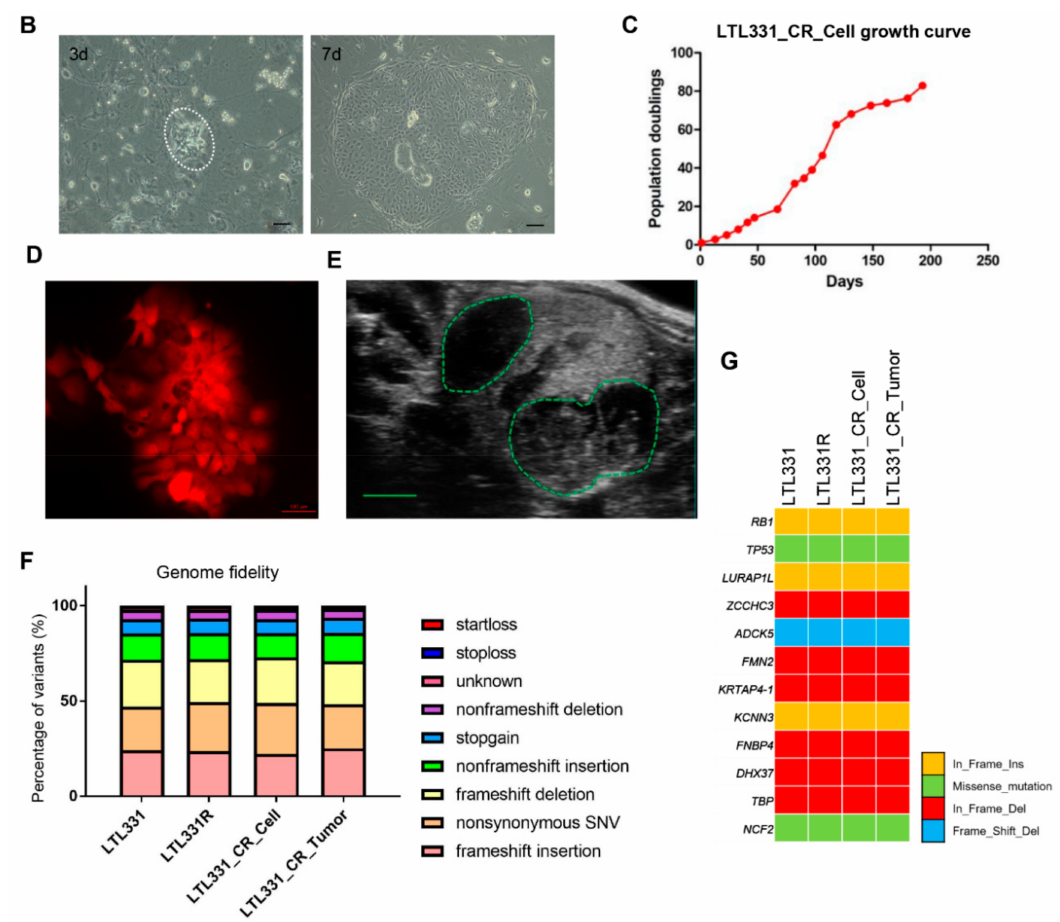
Figure 1. Establishment, application, and molecular characterization of conditionally reprogrammed cells derived from the LTL331 PDX. ( A ) Schematic showing the conditional reprogramming (CR) culture establishment process. The LTL331 prostatic adenocarcinoma PDX can transdi ff erentiate to neuroendocrineprostatecancer(NEPC)(LTL331R)afterhostmousecastration-inducedtumorregression (LTL331_Cas) [10]. Fresh tumor tissue from LTL331 was enzymatically dissociated into single cells. The cells were then cocultured with irradiated 3T3-J2 feeder cells to establish LTL331_CR_Cells. The CR cells were grafted under the renal capsule of host mice to establish CR cells-derived xenografts, namely LTL331_CR_ Tumor. ( B ) Representative images of LTL331_CR_Cells. Under the light microscope, small colonies of epithelial tumor cells can be observed 3 days after initial plating as highlighted by the white dash (left panel). Faster growing large colonies can be observed after one week as shown in the right panel. Scale bar, 200 µ m. ( C ) Growth curve of LTL331_CR_Cell. The CR cells were serially passaged and the cell numbers were recorded at each passage until the culture was terminated. A growth curve of population doublings versus time (days) is plotted. ( D ) Representative image of LTL331_CR_Cell following genetic manipulation. Cells were transduced with lentivirus to express the mCherry fluorescent protein. Scale bar, 100 µ m. ( E ) Representative image of LTL331_CR_Tumor growing under the renal capsule of a mouse. The green dash highlights two tumors grafted in one kidney. Scale bar, 2 mm. ( F – G ) Mutation analysis of expressed transcripts across the LTL331-derived models. Mutation type and frequency was analyzed with RNA-seq data. The percentage of each mutation type is stacked into one bar, with di ff erent types indicated by the corresponding colors ( F ). Representative gene mutations are shown ( G